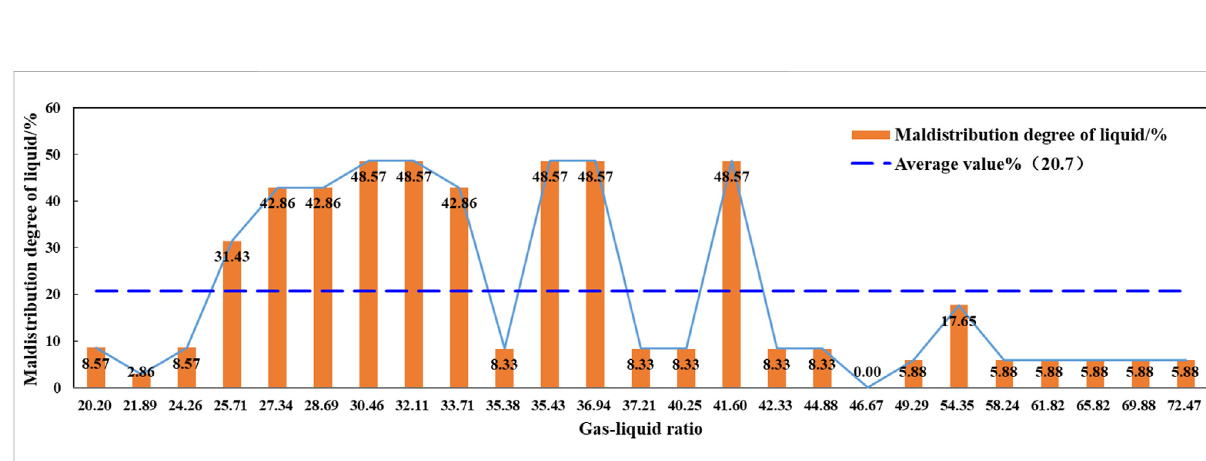
FIGURE 14 Histogramofgas – liquidratioandmaldistributiondegree ofliquidinannular fl owinhorizontalmanifoldwith fl utepipes(liquidinjectionvolume